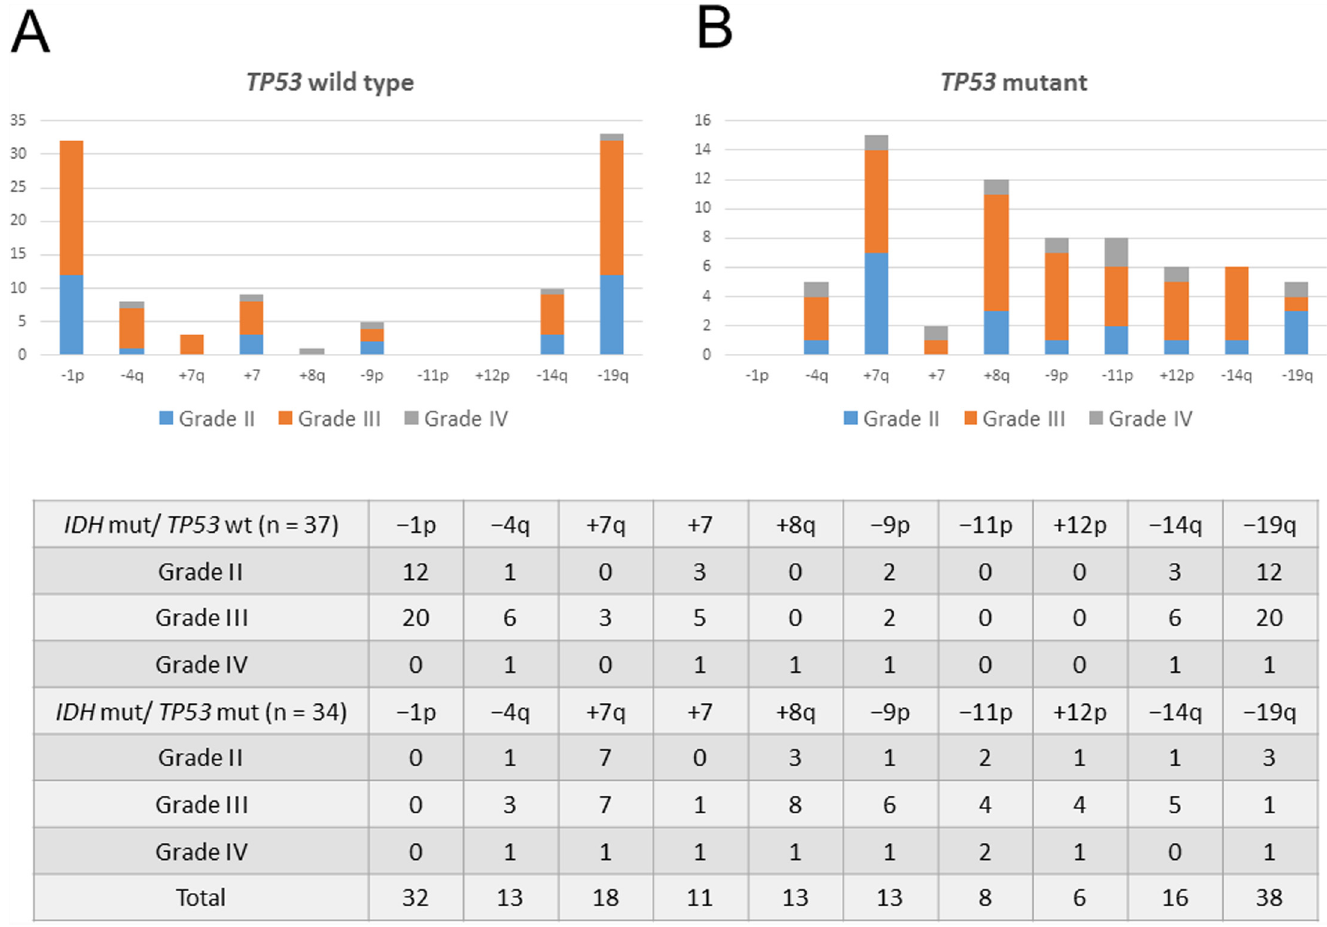
Fig 2. CNAs frequently detected in IDH mutant gliomas. A comparison of CNAs found in IDH mutant gliomas (A) with wild-type TP53 and (B) mutant TP53 . The number of CNAs detected in both IDH mutant gliomas with wild-type and mutant TP53 is summarized in a